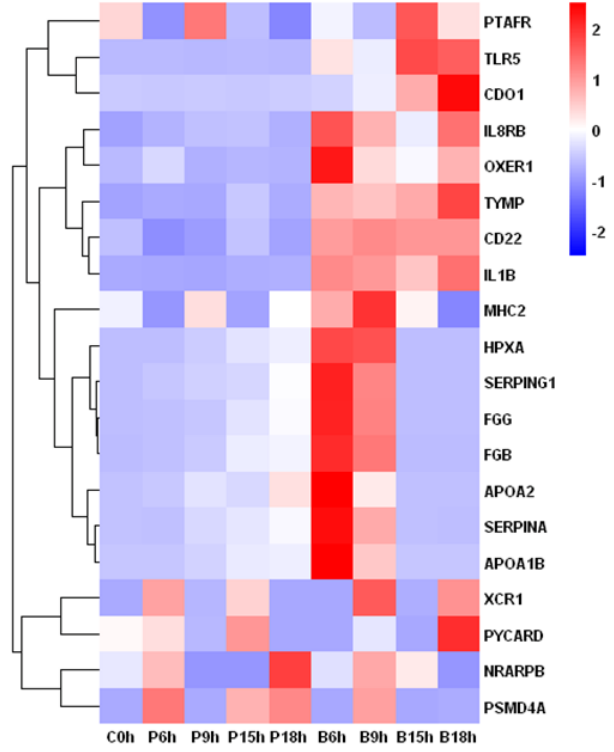
Figure 2. Hierarchical clustering of the top 20 differentially expressed (DE) mRNAs among the nine libraries (C0h, P6h, P9h, P15h, P18h, B6h, B9h, B15h, and B18h). Heatmap of the count data for DE mRNA libraries for the differentially expressed genes.